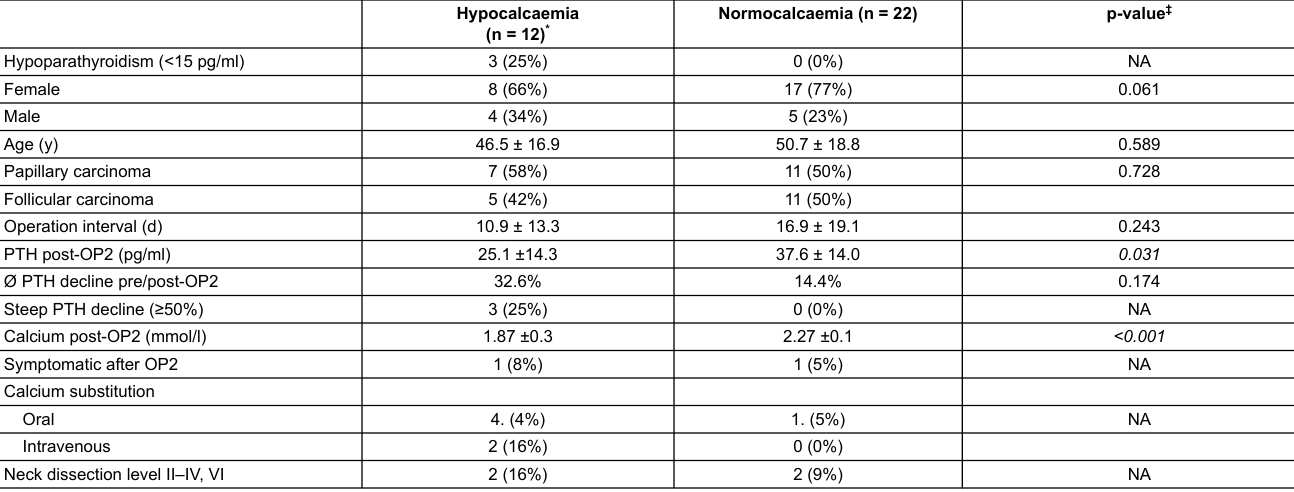
Table 1: Comparison of the cohort showing a significantly higher rate of hypoparathyroidism (<15 pg/ml), lower PTH levels and higher rate of steep PTH decline after second surgery (OP2). Also significantly more calcium substitution either orally or intravenously was necessary in the hypocalcaemia